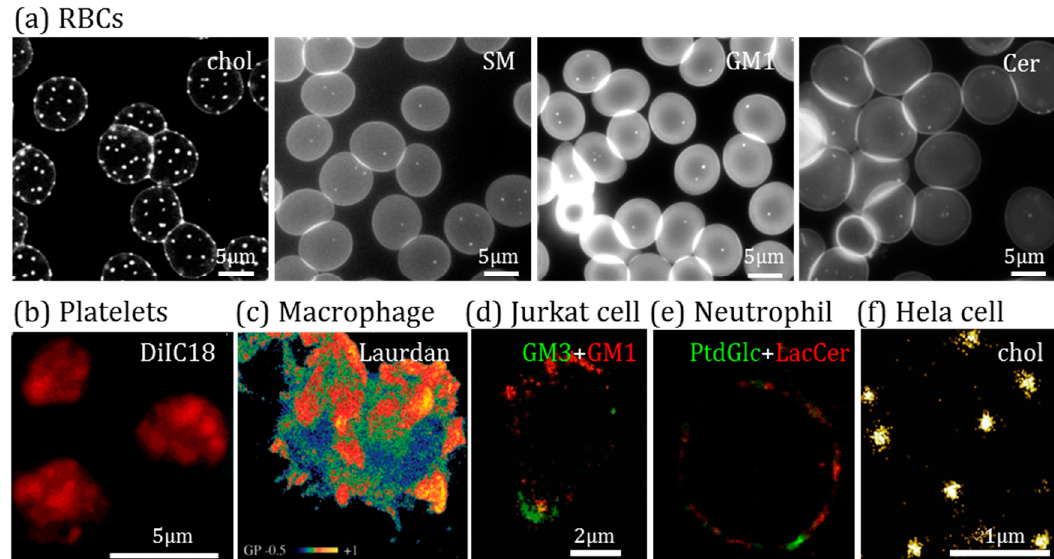
Figure 5. Visualization of plasma membrane lipid domains. ( a ) RBCs labeled for chol with Theta-D4-mCherry or with boron-dipyrromethene-sphingomyelin (BODIPY-SM), -GM1 (BODIPY-GM1) or –ceramide (BODIPY-Cer) and analyzed by fluorescence or confocal microscopy. ( b ) Platelets labeled with DilC18 and analyzed by fluorescence microscopy. ( c ) Macrophage labeled with Laurdan and vizualized by two-photon microscopy. ( d ) Jurkat cell labeled for GM3 and GM1 using anti-GM3 serum and cholera toxin B subunit, respectively, and visualized by confocal imaging. ( e ) Human neutrophil stained for phosphatidylglucoside (PtdGlc) and lactosylceramide (LacCer) and examined by stimulated emission depletion microscopy (STED). ( f ) HeLa cell labeled for chol with Theta-D4-DRONPA and processed by photoactivated localization microscopy (PALM). Adapted from ( a ) [225]; ( b ) [229]; ( c ) [230]; ( d ) [231]; ( e ) [232]; ( f )